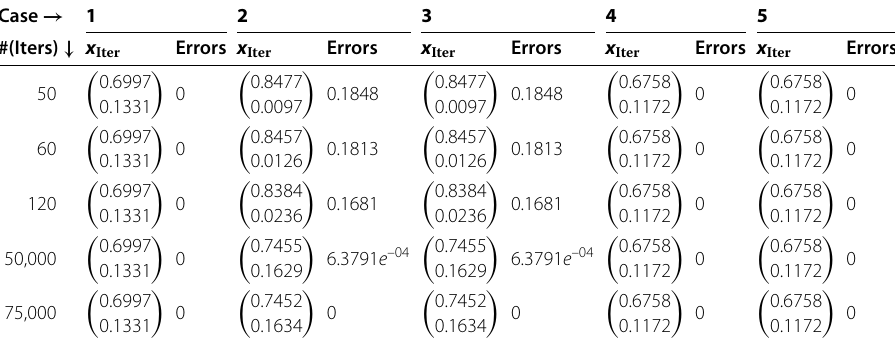
Table 3 Influence of the step size parameters λ n and γ n for the initial vector (1,–1) with the